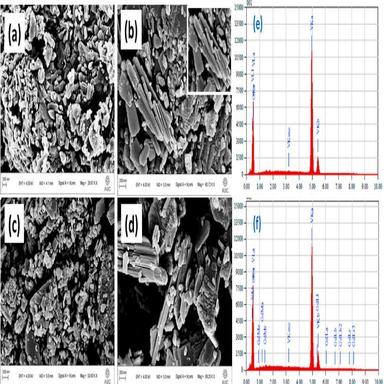
Low and high magnification FESEM micrographs of (a–b) VO and (c–d) GVO, (e–f) EDX spectra of VO and GVO.